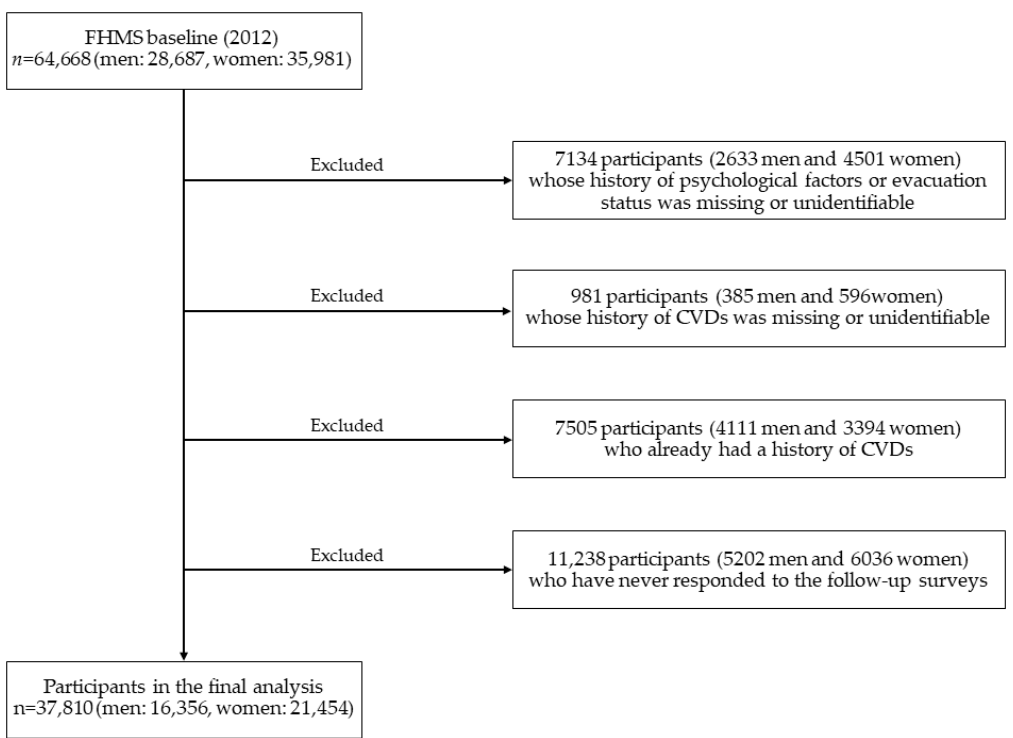
Figure 1. Flowchart of participant selection for this study of association between psychological factors and evacuation status and the incidence of cardiovascular diseases after the Great East Japan Earthquake.